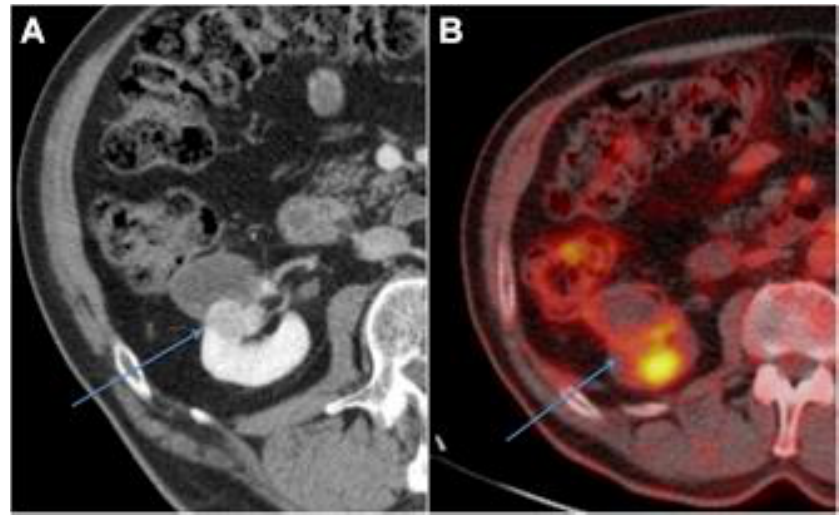
Figure 4. Local RCC recurrence of RM-CA. At 8 months following LCA for patient number 6, a focal contrast-enhanced area at the posterior side within the ablation zone was noticed on contrast- enhanced CT scan ( A , blue arrow). Although not as sharply distinctive as the contrast-enhanced CT scan, we noticed metabolic activation in the same posterior rim area at 18F-FDG PET-CT scan ( B , blue